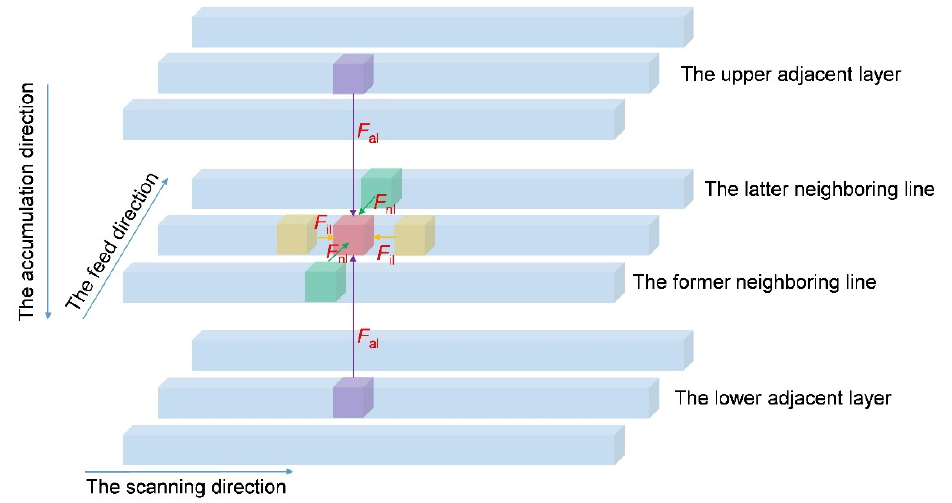
Figure 7. The force analysis for a single microparticle in the SLA.